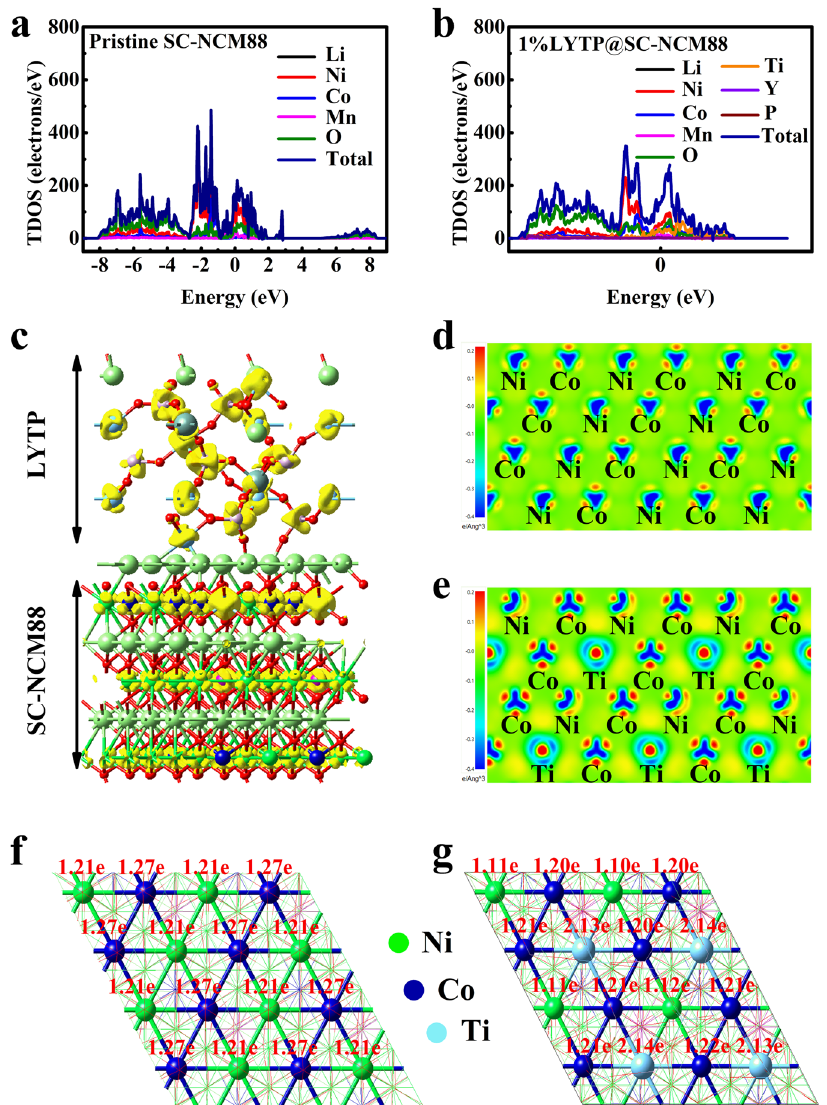
Fig. 7 Density functional theory calculation. The total and partial density of states plots for ( a ) pristine SC-NCM88 and ( b ) 1% LYTP@SC-NCM88. c Relaxed crystal structures of 1% LYTP@SC-NCM88. The corresponding 2D charge difference scheme and Bader charge transfer for ( d , f ) pristine SC- NCM88 and ( e , g ) 1%